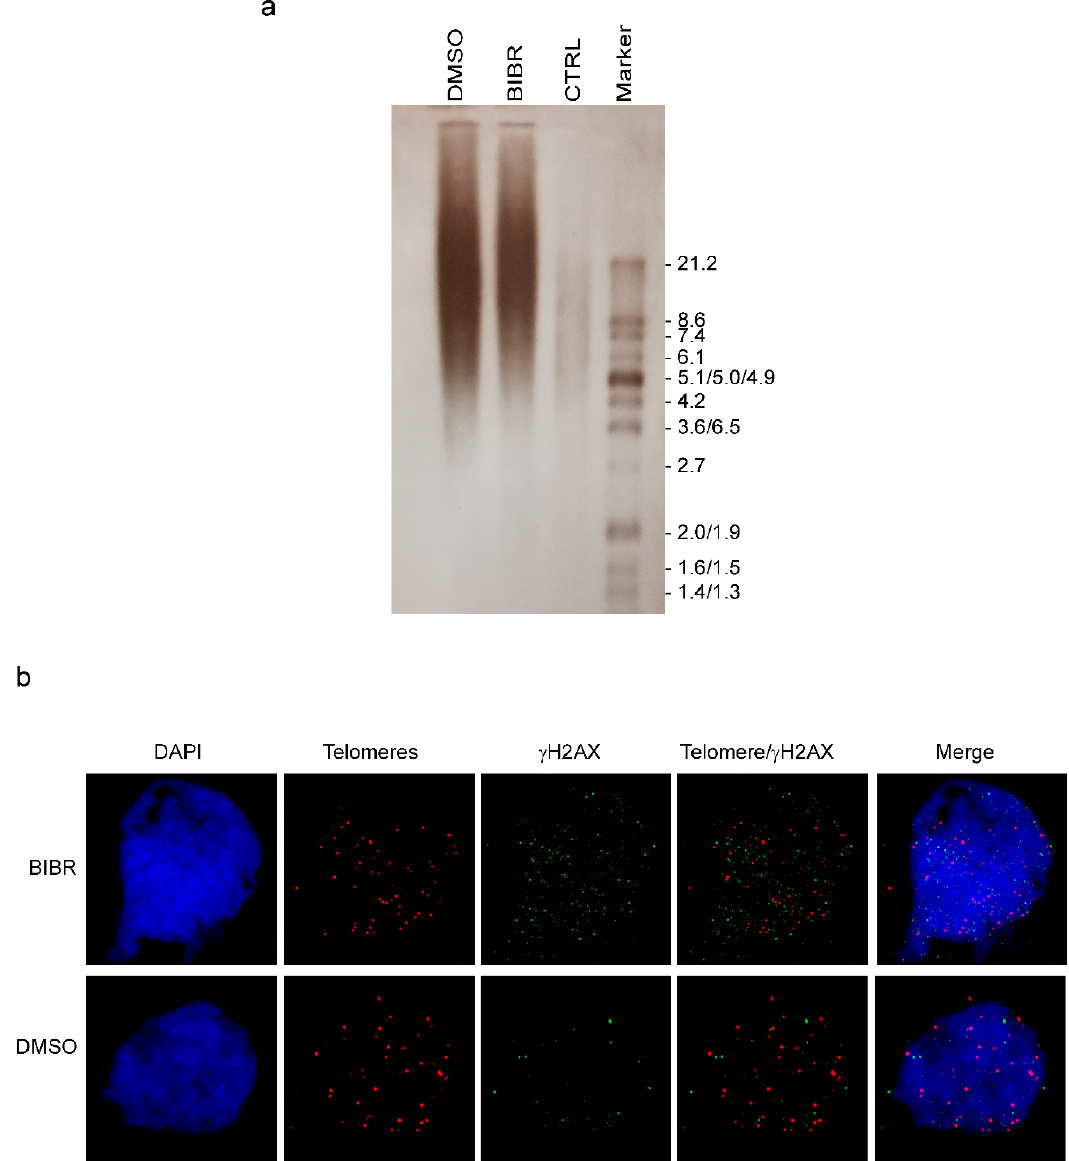
Figure 3. Short-term Tert inhibition does not affect telomeres. ( a ) DNA from wt embryos treated with BIBR or DMSO for 36 h, from 12 to 48 hpf, was employed to visualize the range of telomere length assessed by terminal restriction fragment (TRF) analyses. A panel from one representative experiment is shown. CTRL (control) DNA from TeloTAGGG kit. ( b ) Telomere dysfunction-induced foci (TIF) analysis. Representative micrographs showing the combined telomere fluorescence in situ hybridization (FISH) / γ H2AX immunofluorescence of wt zebrafish cells from embryos treated with BIBR or DMSO, from 12 to 24 hpf. From the left: 4 (cid:48) ,6-diamidino-2-phenylindole (DAPI) (nuclear marker, blue), telomere probe (red), γ H2AX (DNA damage marker, green), combined telomere / γ H2AX, and the merged image. Magnification: 100 ×